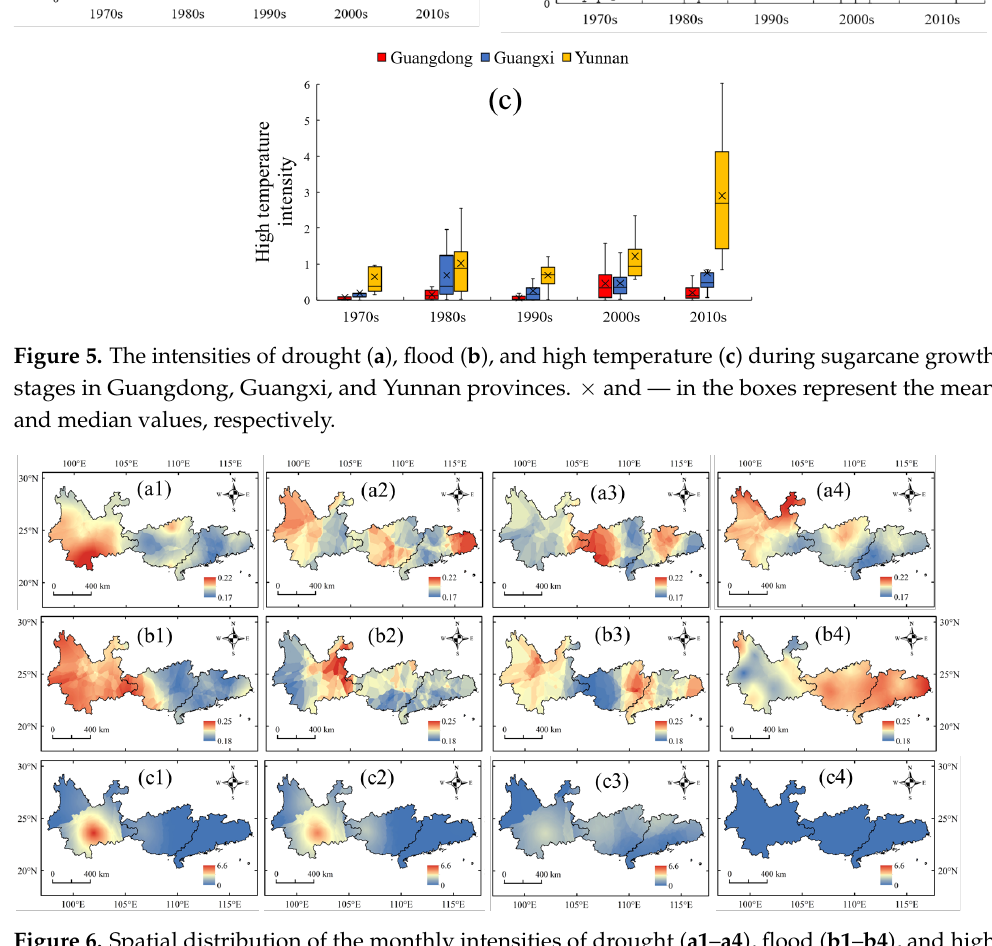
Figure 6. Spatial distribution of the monthly intensities of drought ( a1 – a4 ), flood ( b1 – b4 ), and high temperatures ( c1 – c4 ) during the seedling ( a1 , b1 , c1 ), tillering ( a2 , b2 , c2 ), stem elongation ( a3 , b3 , c3 ), and mature stages ( a4 , b4 , c4 ) of sugarcane in southern China. The intensities were averaged over 1970 – 2020 and displayed here for spatial analysis.